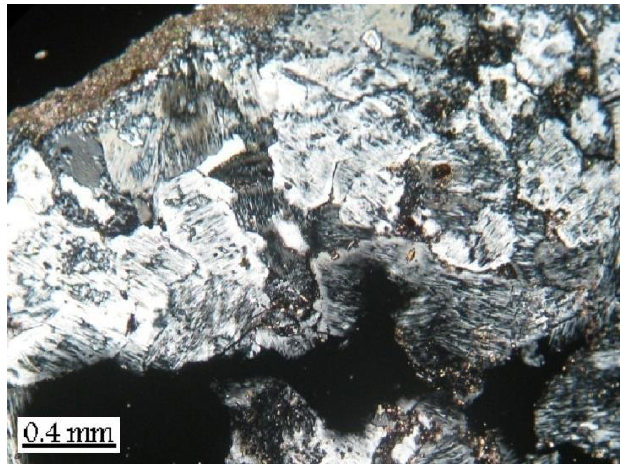
Figure 10. Recrystallization phenomenon in the studied